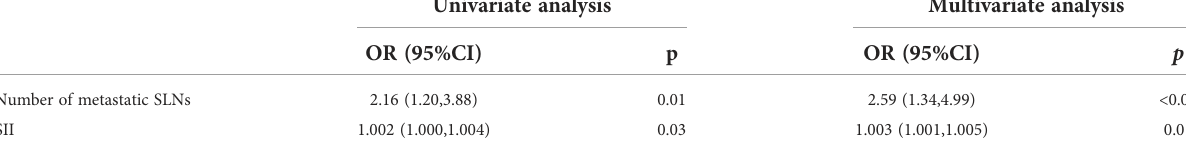
TABLE 4 Logistic regression for Number of metastatic SLN and SII.